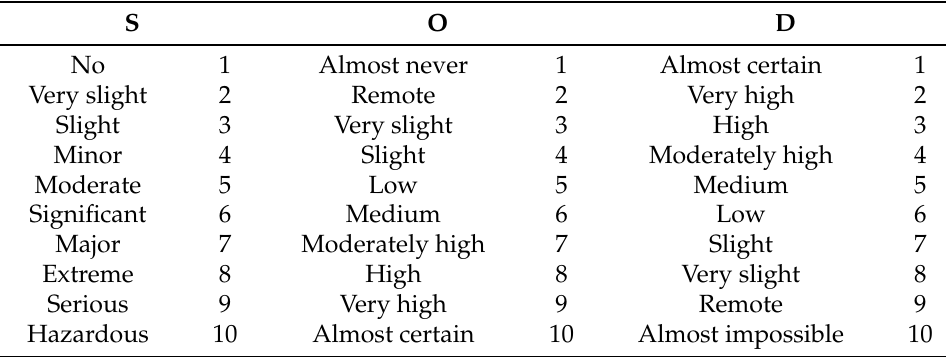
Table 3. Evaluation scale to determine the SOD